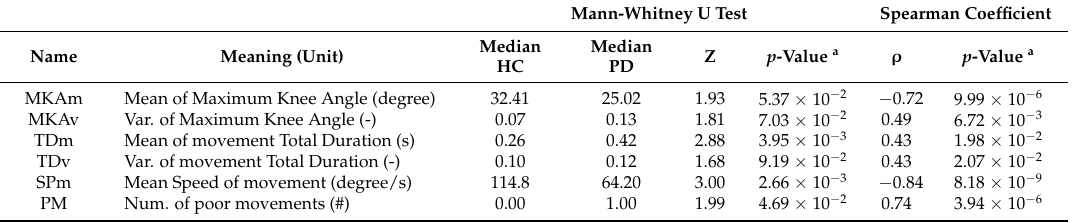
Table 5. Parameters of the LA task: discriminant power and correlation with UPDRS scores.